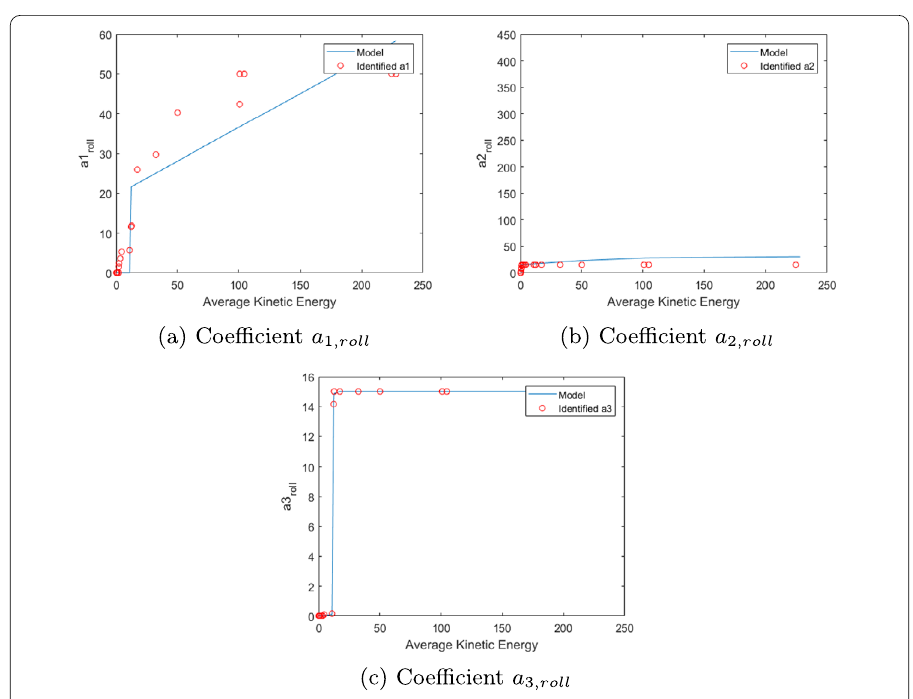
Figure 22 Comparison between the coefficients against their models for the roll